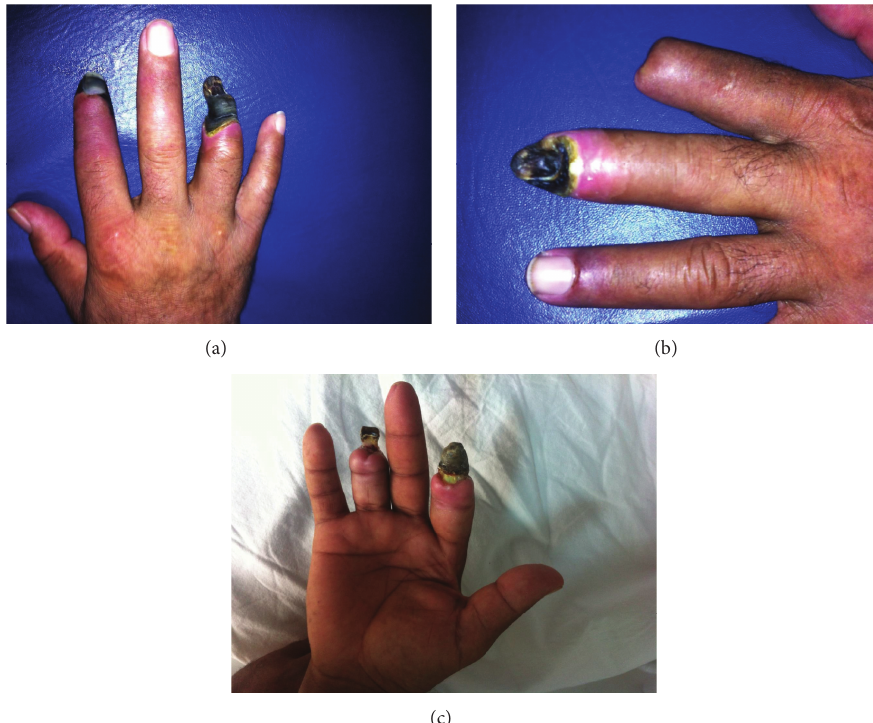
Figure 1: (a) Right hand showing digital gangrene on the index and fourth fingers, (b) left hand showing digital gangrene of third finger, and (c) six months after aggressive therapy.